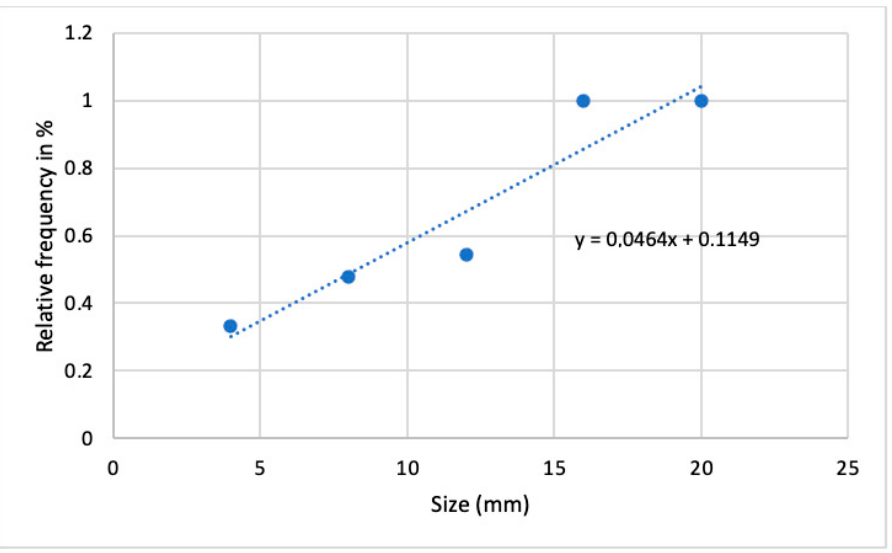
Figure 4. Linear correlation between metastasis size and detection frequency on PET/CT scan.